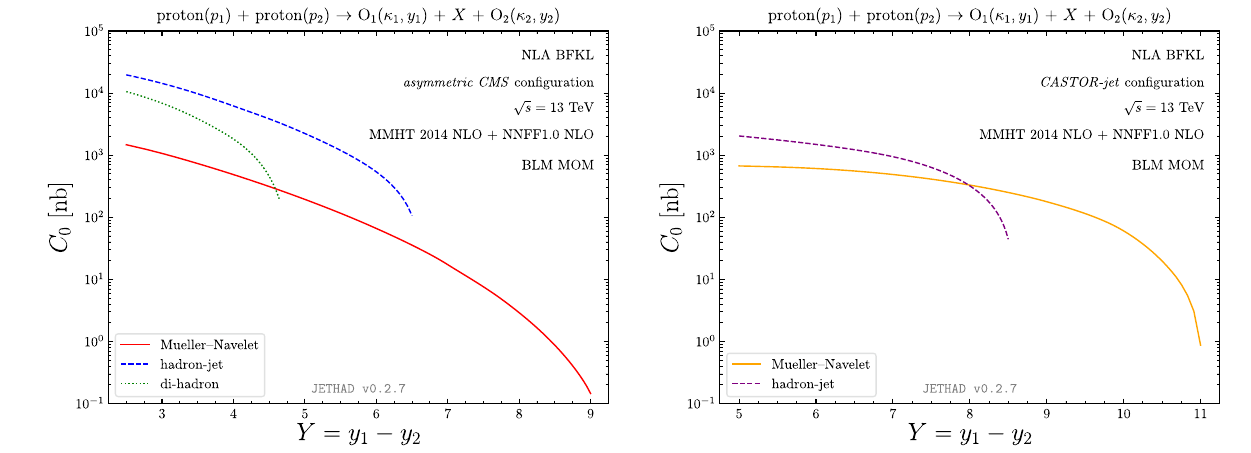
Fig. 7 Y -dependence of the ϕ -averaged cross section, C 0 , for the three considered reactions (Fig. 2) in the NLA BFKL accuracy. Results for √ s = 13 TeV in the asymmetric CMS ( CASTOR-jet ) configuration are